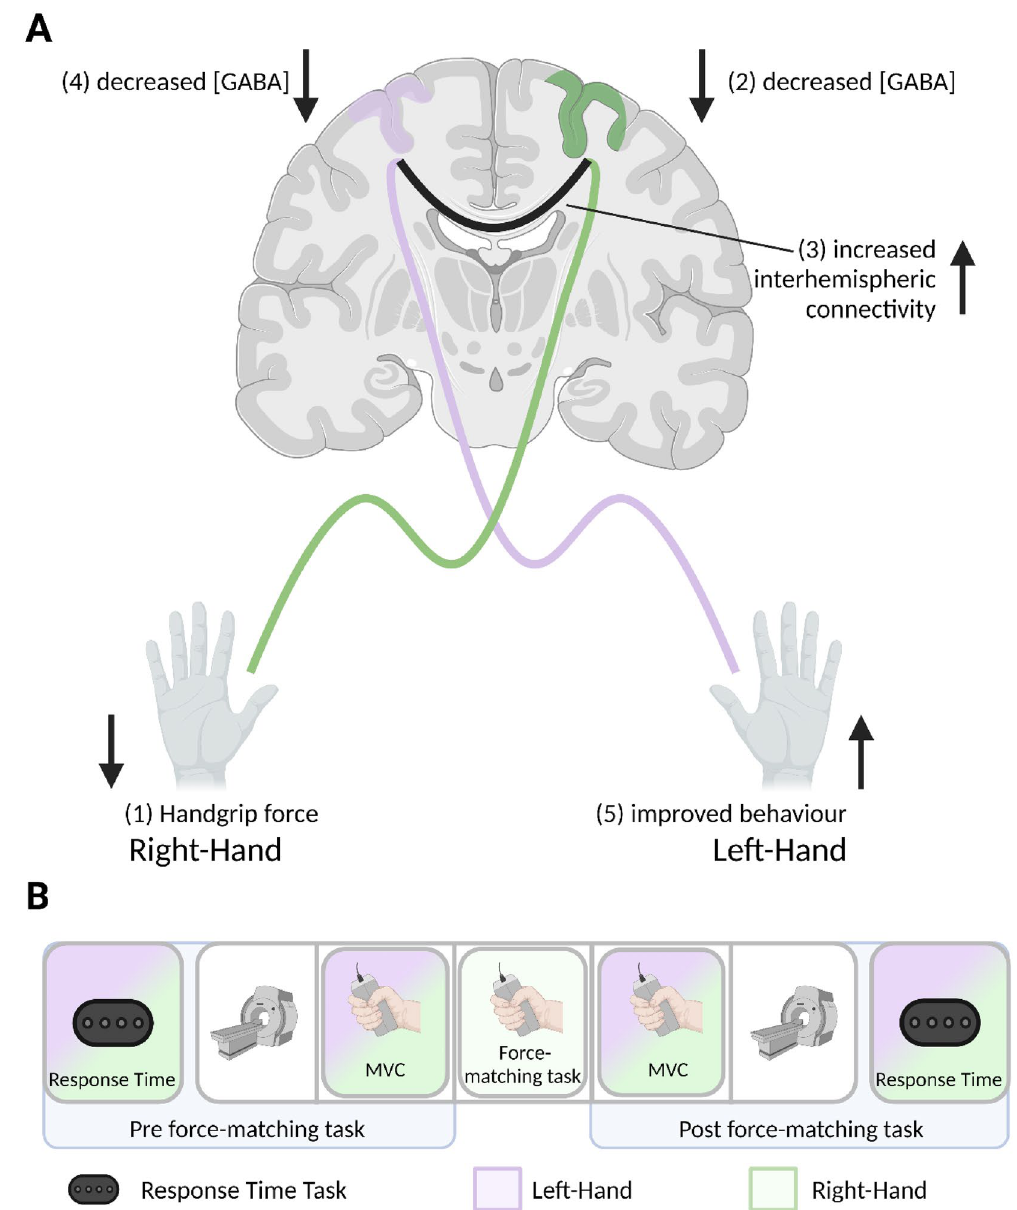
Figure 1. ( A ) Theoretical physiological model for the present study, ( B ) Schematic outlining the study design. MVC = maximum voluntary contraction; Force-matching task = nine-minutes of 0.5 Hz right handgrip contractions performed at either 5% or 50% MVC. This figure was created with